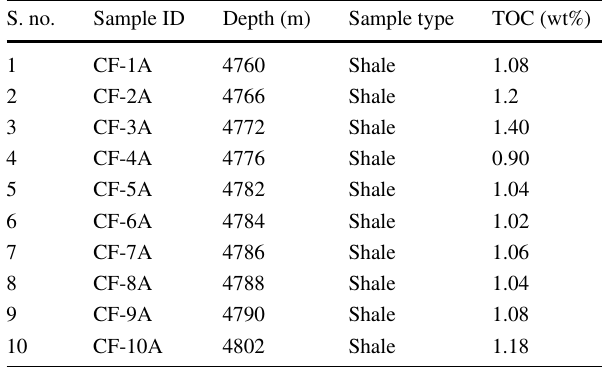
Table 2 The TOC results of Mela-05 drill cuttings of the Chichali Formation